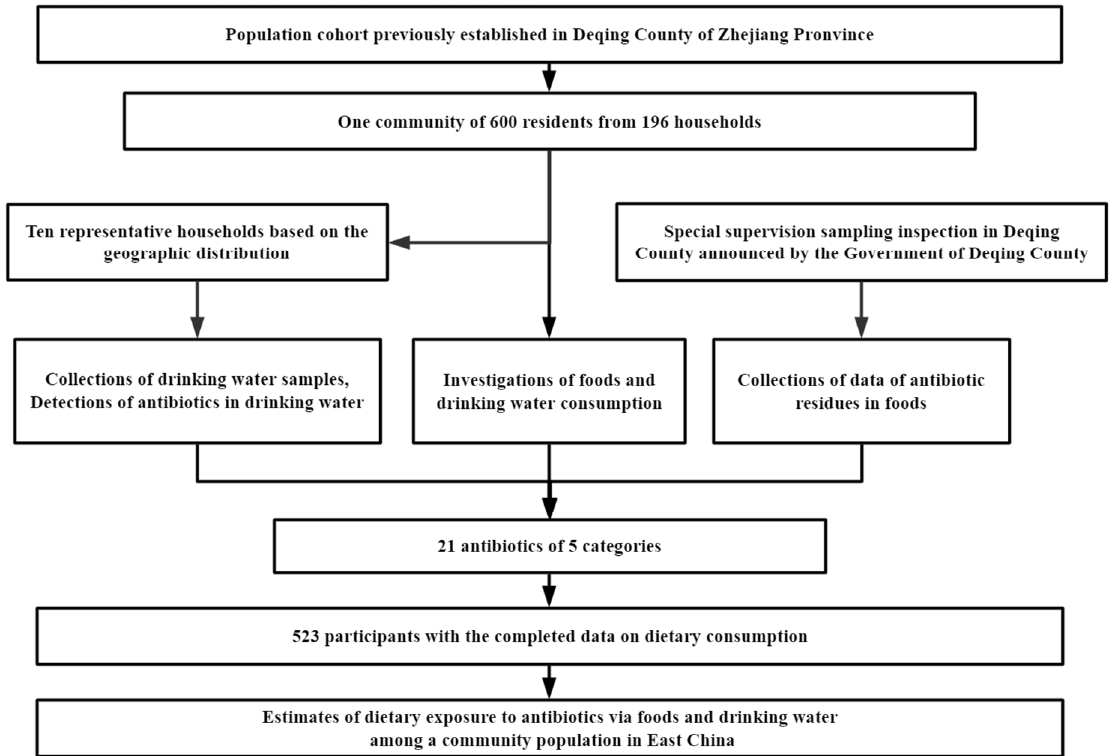
Figure 1. Flow chart for the study.